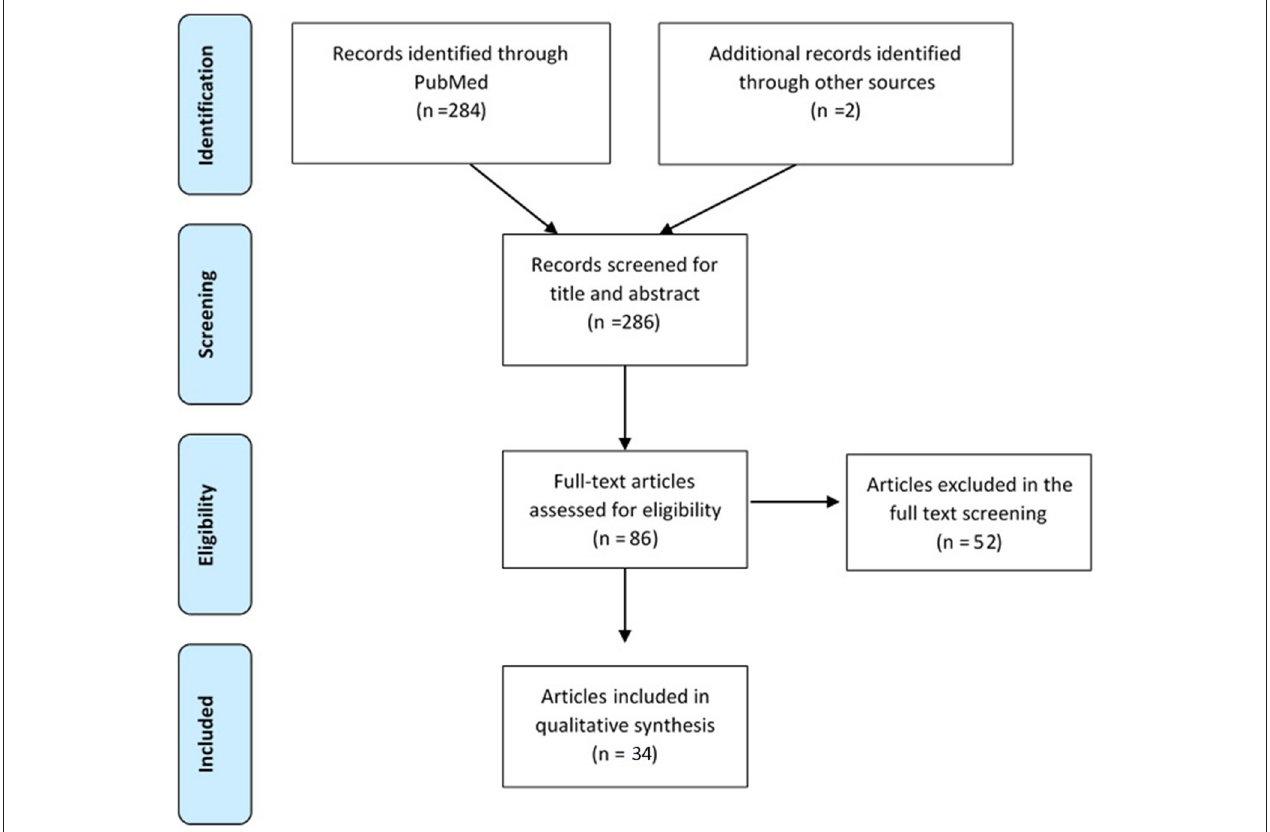
FIGURE 1 | Flow-diagram of articles screened in the scoping literature